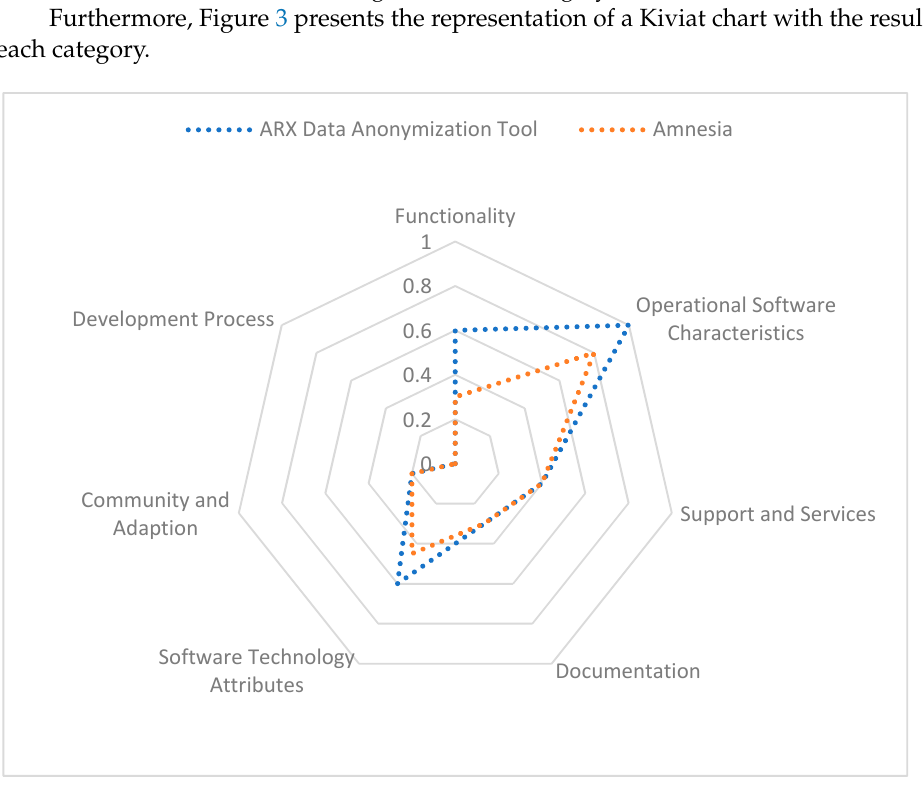
Figure 3. Kiviat chart with OSSpal results.